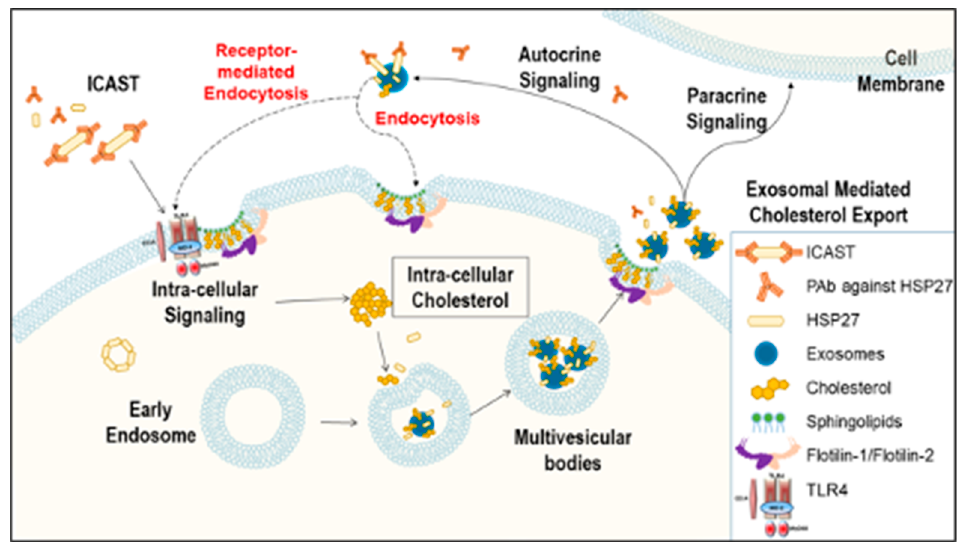
Figure 5. Working model for HSP27 Immune Complex Altered Signaling and Transport (ICAST) modulation of cholesterol efflux. The HSP27 Immune Complex Altered Signaling and Transport unit (or exosomes containing HSP27 + anti-HSP27 antibody) trigger intracellular signaling that modulates the release of cholesterol loaded exosomes. For example, expression of Flotillin-2 is increased, and the cholesterol loaded into exosomes, as well as the number of exosomes released is enhanced. Once the exosomes are released to the extracellular space, they may act via autocrine or paracrine signaling, or proceed to cholesterol disposal via yet to be elucidated mechanisms.